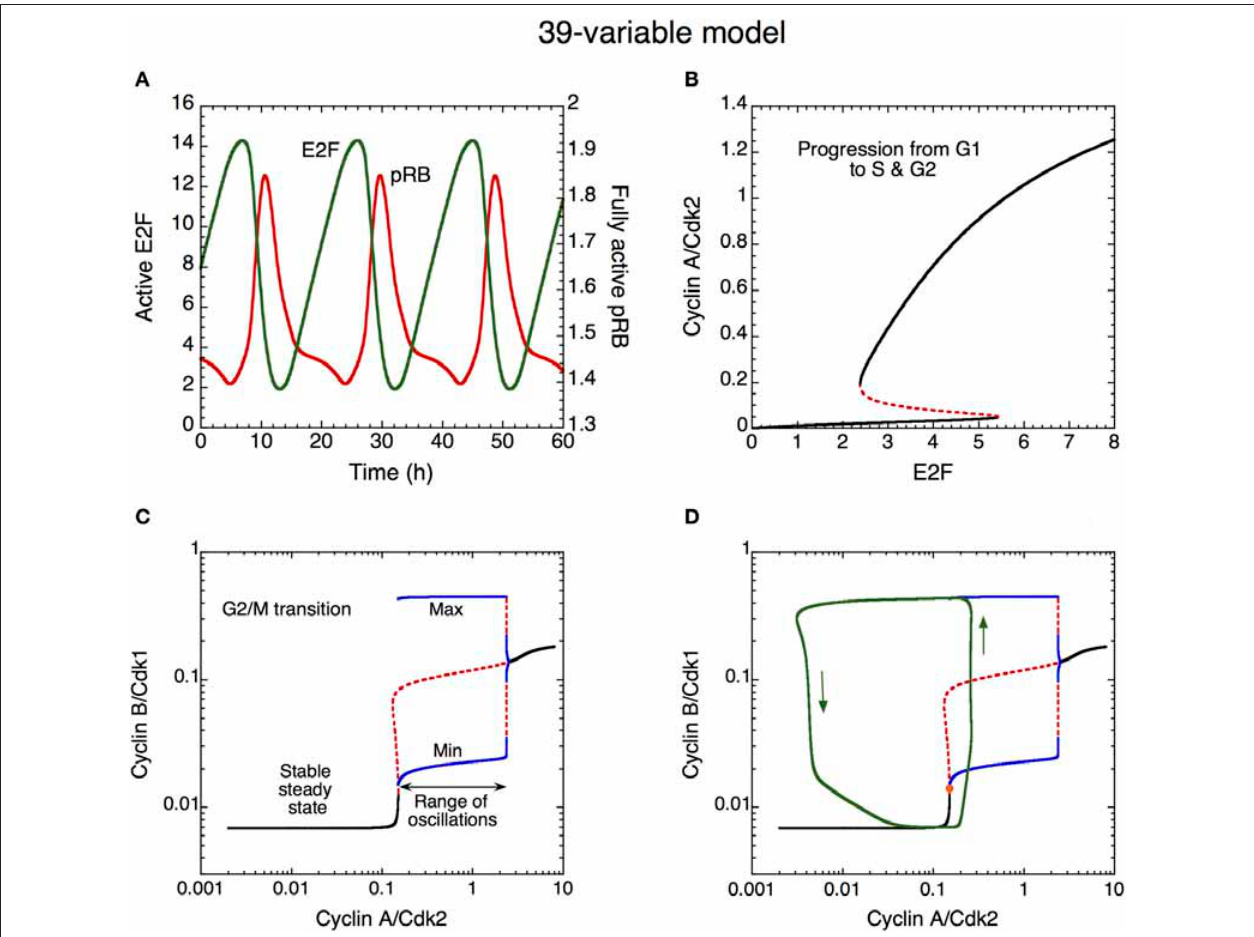
FIGURE 10 | Mechanism of oscillations in the Cdk network. (A) The curves show the time evolution of the active, unphosphorylated, forms of E2F (in green) and pRB (in red) which oscillate in antiphase. (B) Bifurcation diagram showing the steady-state level of cyclin A/Cdk2 as a function of E2F, considered as a parameter. Two stable steady states coexist in the domain of bistability. The sharp increase in cyclin A/Cdk2 above a critical level of E2F favors progression from the cell cycle phase G1 to S and G2. (C) Bifurcation diagram showing the steady-state level of cyclin B/Cdk1 as a function of cyclin A/Cdk2, considered as a parameter. A domain of sustained oscillations exists above a critical level of cyclin A/Cdk2; the upper and lower blue curves denote the maximum and minimum of cyclin B/Cdk1 oscillations as a function of cyclin A/Cdk2. The rise in the level of cyclin A/Cdk2 pushes transiently the system into the domain of sustained oscillations, which permits the activation of cyclin B/Cdk1 at the G2/M transition. The rise in cyclin B/Cdk1 leads to the activation of the protein Cdc20, which promotes the degradation of cyclins A and B; this creates a negative feedback loop in the activation of cyclin A/Cdk2 and cyclin B/Cdk1. The subsequent decrease